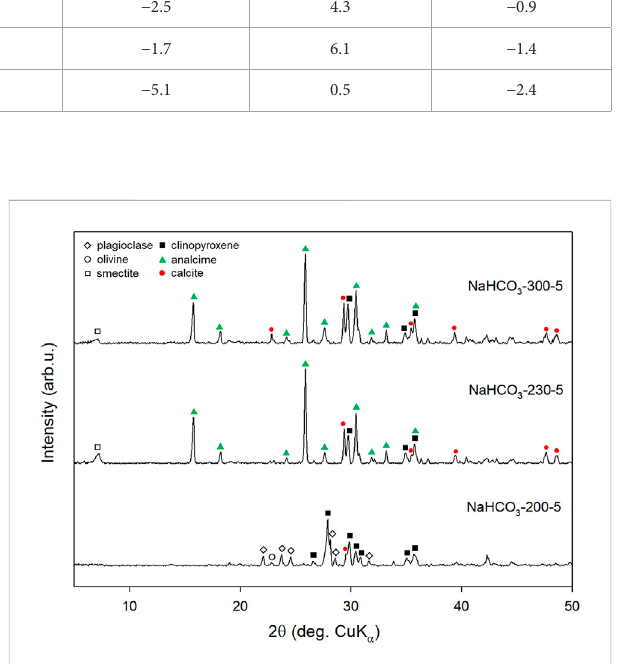
FIGURE 7 XRD patterns of solid samples collected after reacting basalt